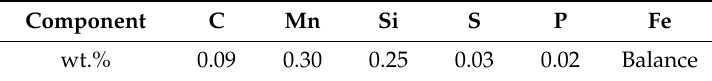
Figure 1. Schematic diagram of dual-beam laser welding of tailored blanks with different thicknesses. Table 1. Chemical compositions of steel plate (wt.%).